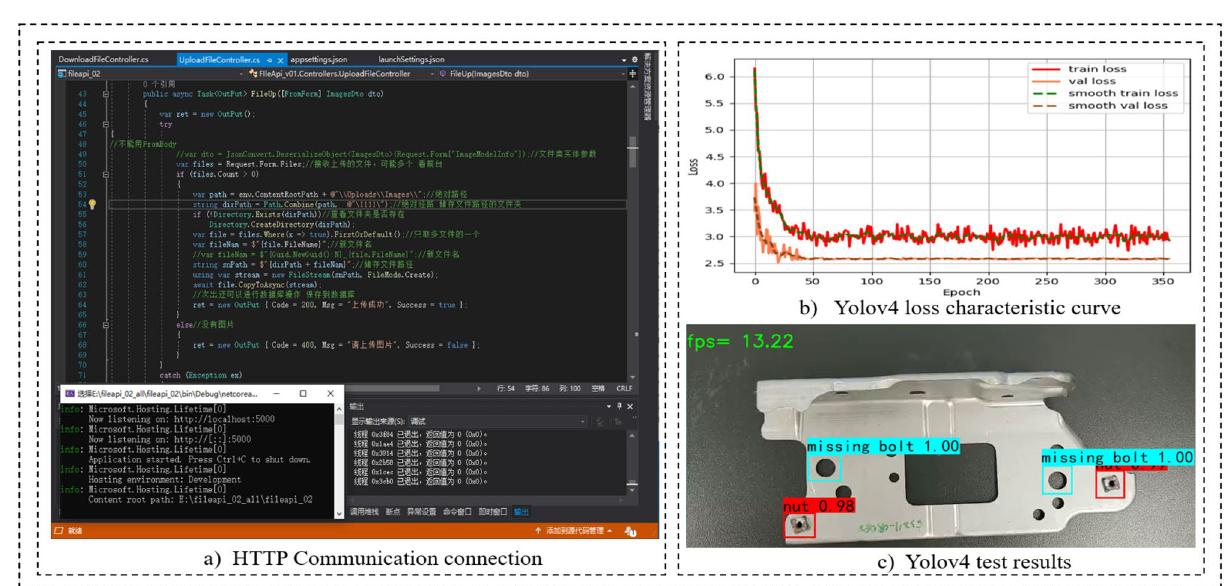
Figure 6. Welding completeness detection based on